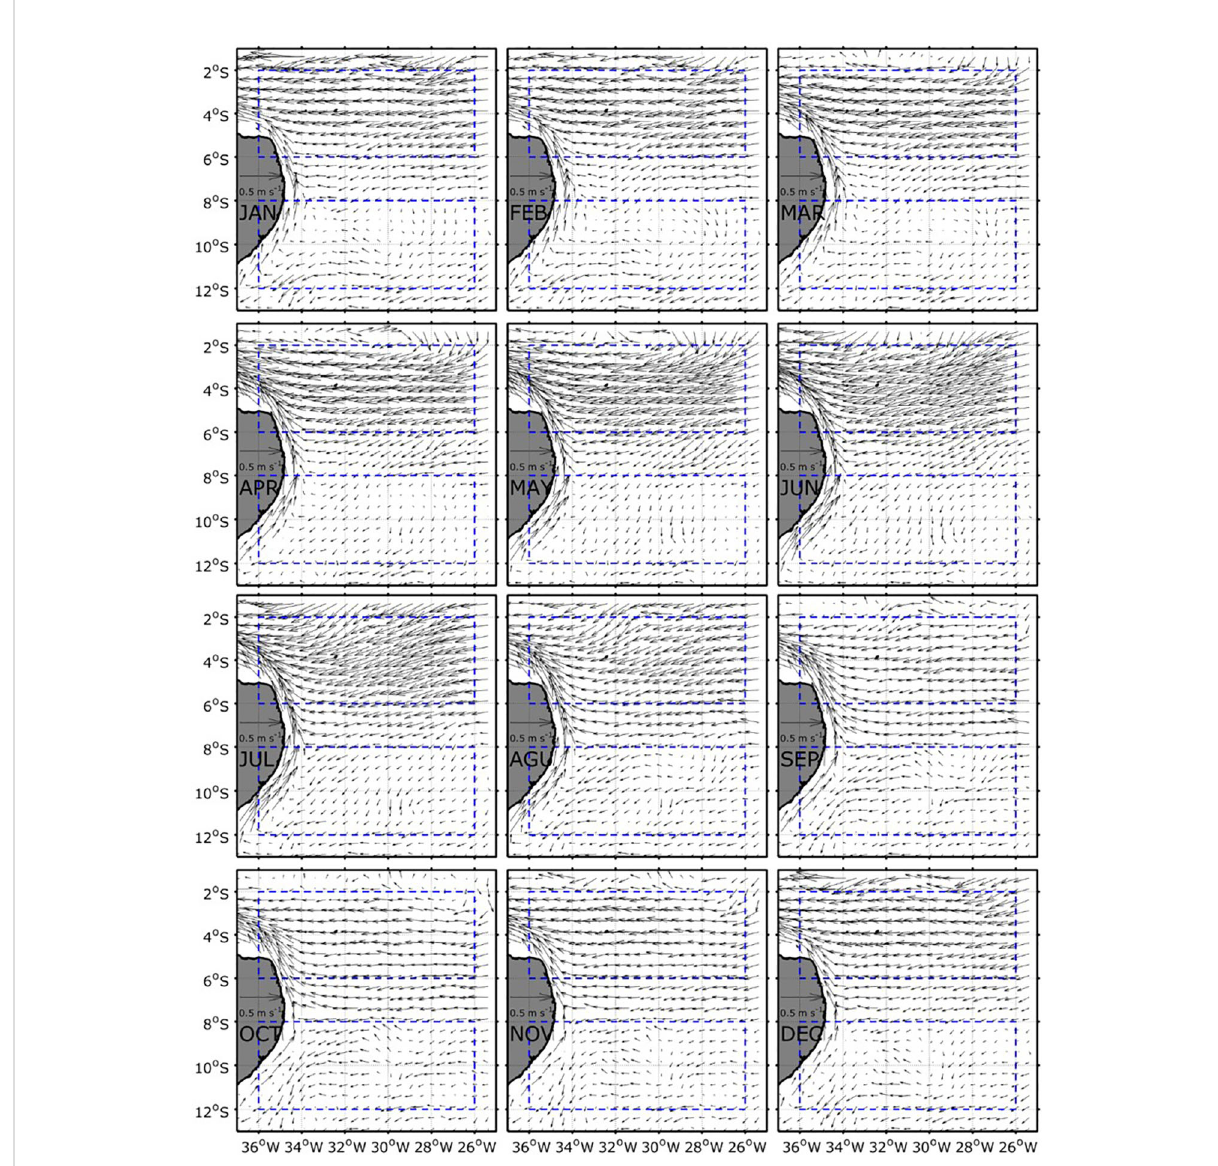
FIGURE 10 Mean monthly (1979 - 2015) map of surface currents from drifter off